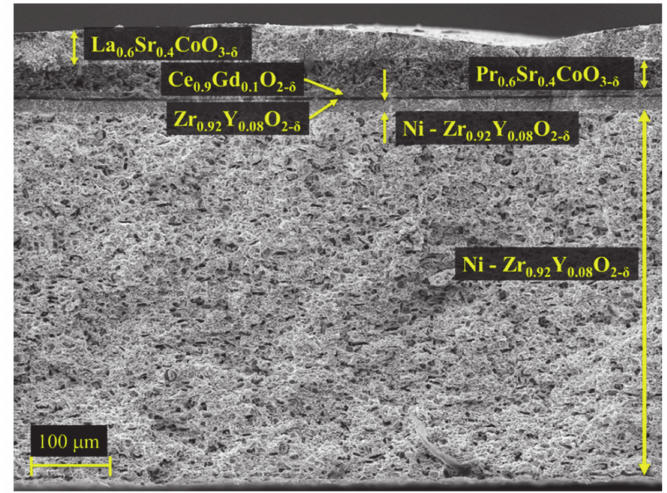
Figure 1. SEM image of a cross section of the SOFC after the experiment. The cell is supported by a 470 µ m thick Ni-YSZ electrode with a 17 µ m thick active fuel electrode layer. The YSZ electrolyte is